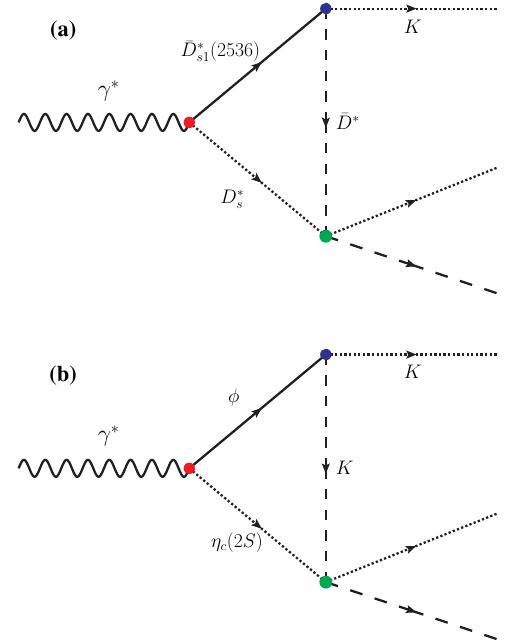
Table 1. Data are needed to constrain the relative normal- ization of the different amplitudes, so at present the m ¯ D ∗ s D ∗ 0 spectrum can not be predicted. However, after convolution ¯ D ∗ D ∗ 0 K + a with the three-body phase space of e + e − → s ( 1525 ) K ∗ trian- clear peak around 4.12 GeV appears to enhance the produc- 2 .The Z ∗ oftensornatureissuppressed tionofaxialvector Z ∗ cs cs in this mechanism due to its involvement of D -wave at least for the total production amplitudes, so it serves a possible ¯ D ∗ with J P . Interestingly γ ∗ D s 1 experimental criteria of Z ∗ cs